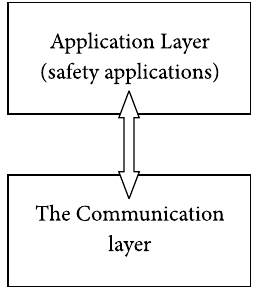
Fig. 2. The two layer